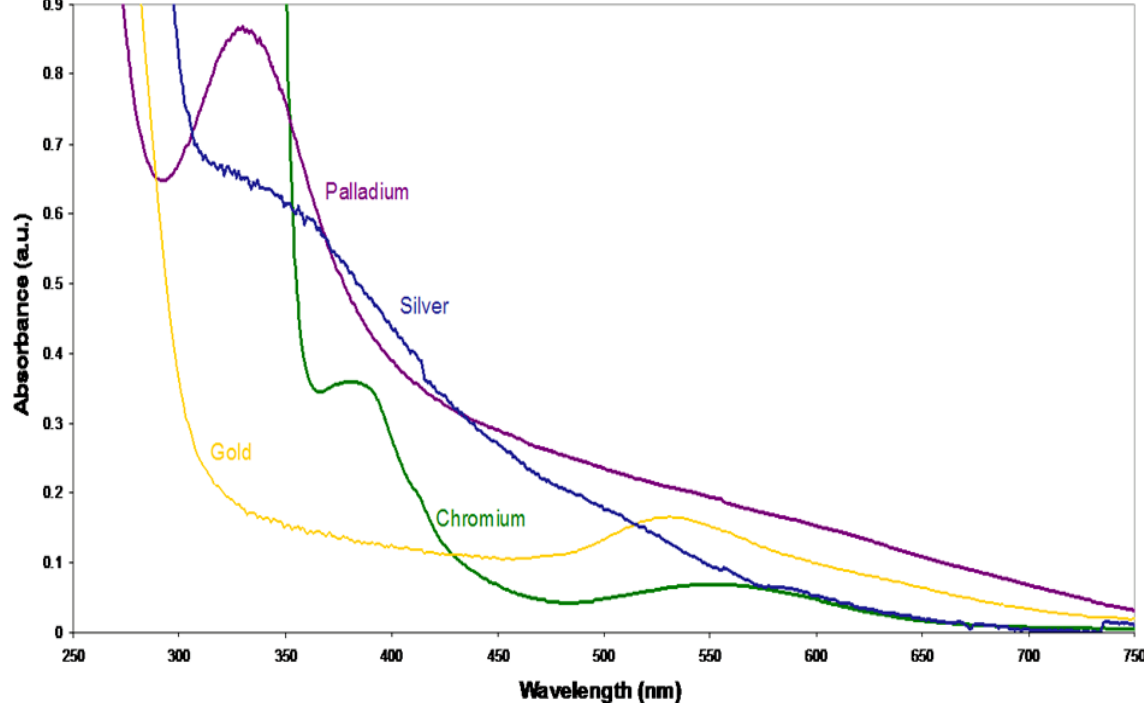
Figure 8. The UV-visible spectra of nanoparticles of palladium (purple), silver (blue), and chromium (green) compared to that of gold (yellow) are consistent with data reported